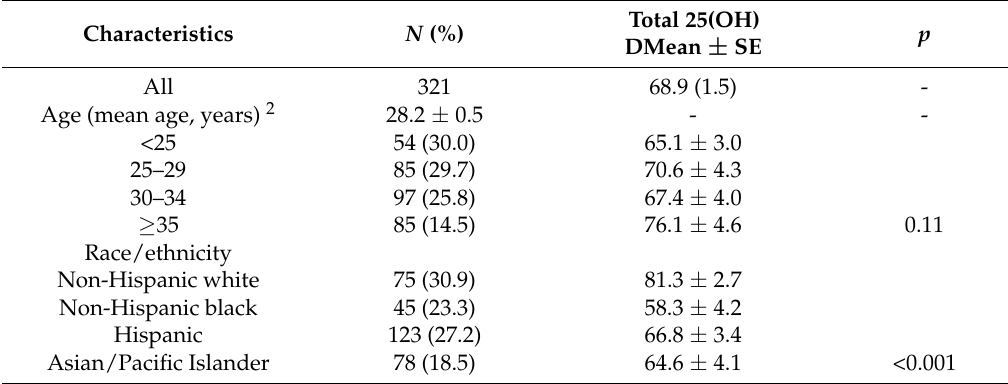
Table 1. Characteristics and maternal 25(OH)D nmol/L concentrations at enrollment 1